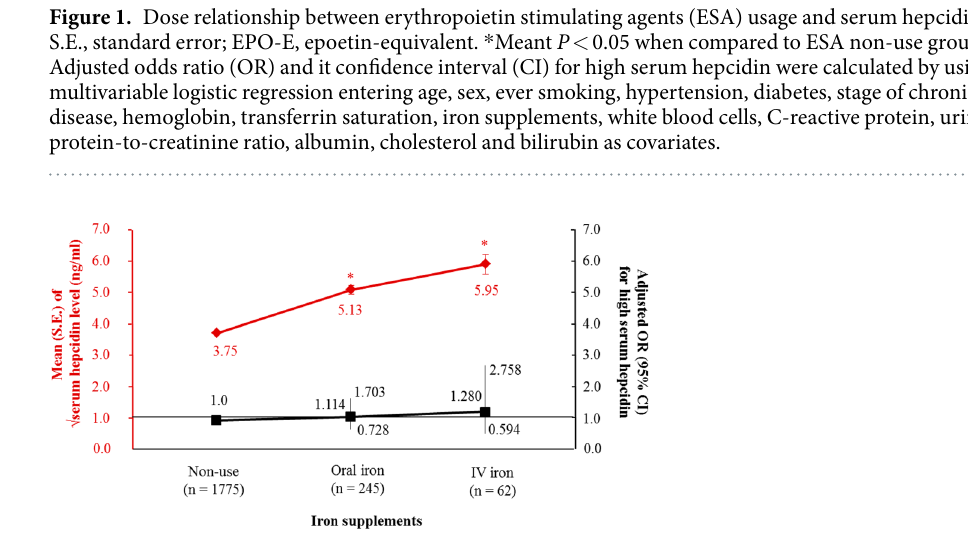
Figure 2. Dose relationship between route of iron supplements and serum hepcidin level. S.E., standard error; IV, intravenous. * Meant P < 0.05 when compared to non-use group. Adjusted odds ratio (OR) and it confidence interval (CI) for high serum hepcidin were calculated by using multivariable logistic regression entering age, sex, ever smoking, hypertension, diabetes, stage of chronic kidney disease, hemoglobin, transferrin saturation, iron supplements, white blood cells, C-reactive protein, urine protein-to-creatinine ratio, albumin, cholesterol and bilirubin as